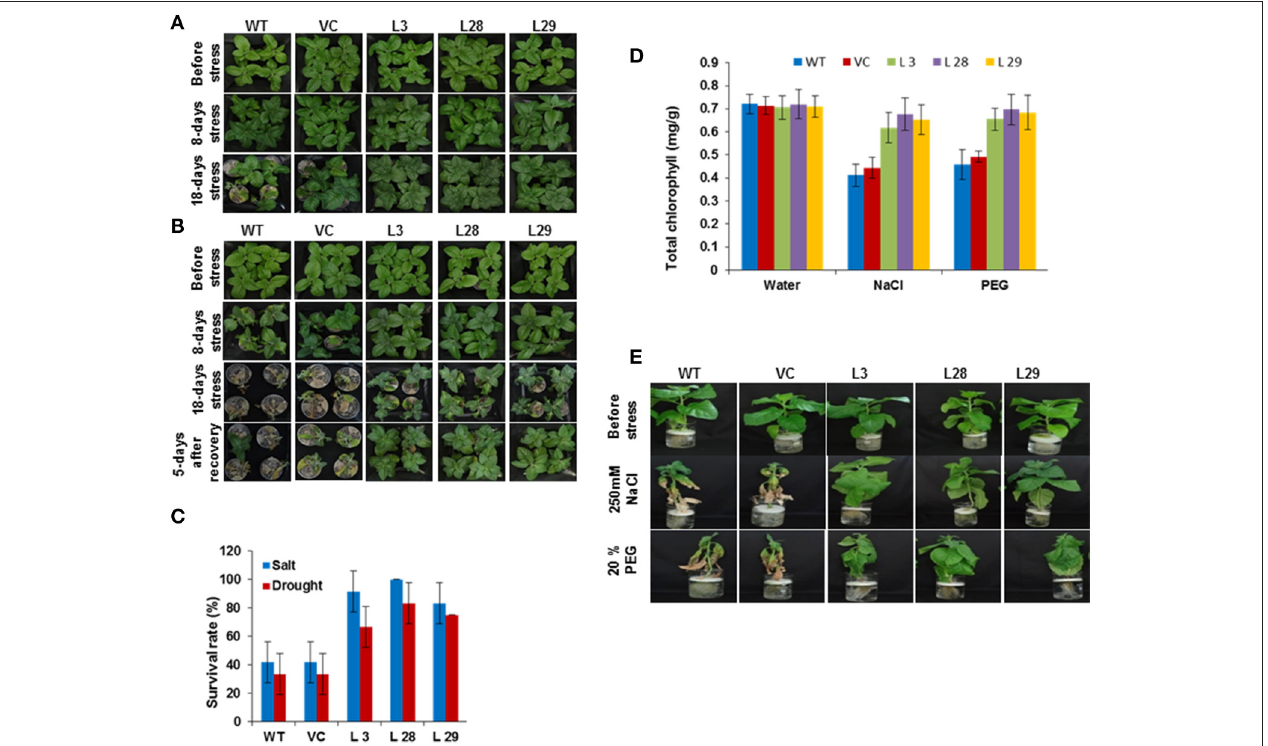
FIGURE 3 | Response of wild-type (WT), vector control (VC), and SbSLSP T2 transgenic tobacco plants under salt and drought stress. (A) Five-week-old transgenic lines (L 3, L 28, L 29, VC) and WT were irrigated with NaCl solution (250mM) for 18 days. Photographs of representative seedlings were taken at the initial stage of salt stress, 8 days after stress, and 18 days after stress. (B) The water supply of 5-week-old normal-growing transgenic lines (L 3, L-28, L-29, VC) and WT was depleted 18 days. Photographs of representative seedlings were taken at the initial stage of drought stress, 8 days after stress, 18 days after stress, and 5 days after re-watering. (C) Quantitative analysis of survival of transgenic lines and WT plants during stress. Values are the mean ± SD (triplicate measurements; n = 4 plants). (D) Quantification of chlorophyll retention from the leaf-disc assay. Values are the mean ± SD of three independent assays. (E) Representative photographs of 6-week-old transgenic plants (L 3, L 28, L 29, VC) grown in 250mM NaCl or 20% PEG compared to WT for 3